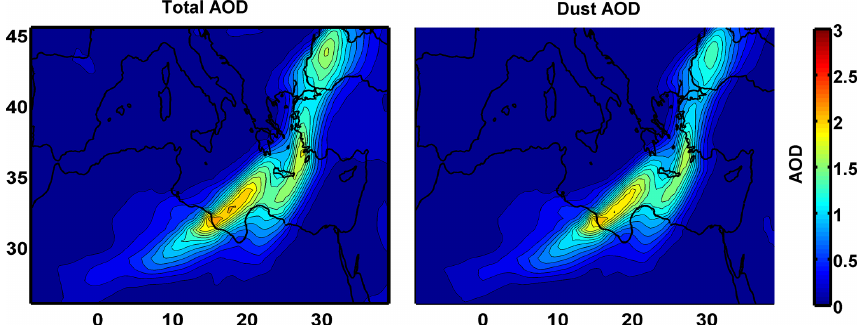
Figure 9. The spatial extent of total AOD (left) and dust AOD (right) at 550nm provided by the CAMS. These maps depict predictions by the MACC 1-day forecast (spatial resolution: 0 . 4 ◦ × 0 . 4 ◦ ). The maps correspond to 12:00UTC, when maximum AOD ≈ 2 . 3. The temporal resolution of the forecast is